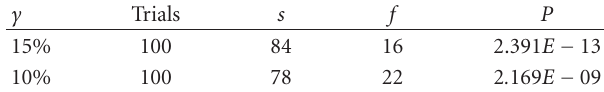
Table 4 addresses the question of how less stealth ( γ =